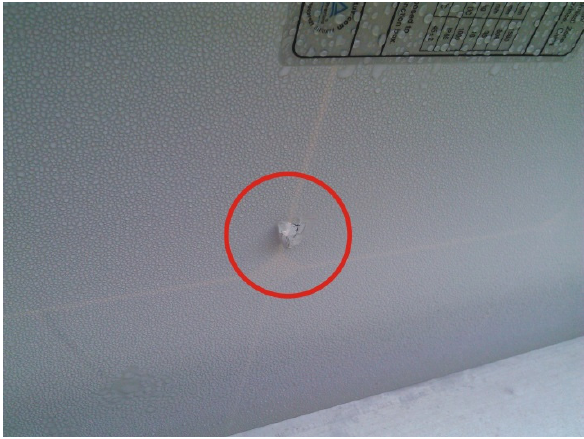
Figure 13. Mechanical damage to PV panel caused by chucked stone